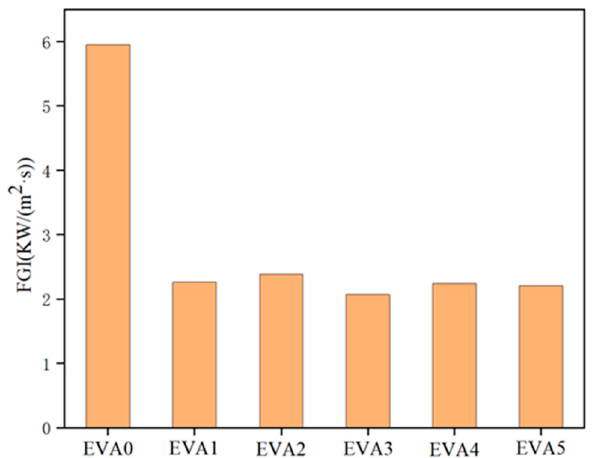
Figure 12. Fire growth index for neat EVA and EVA/MH composites.